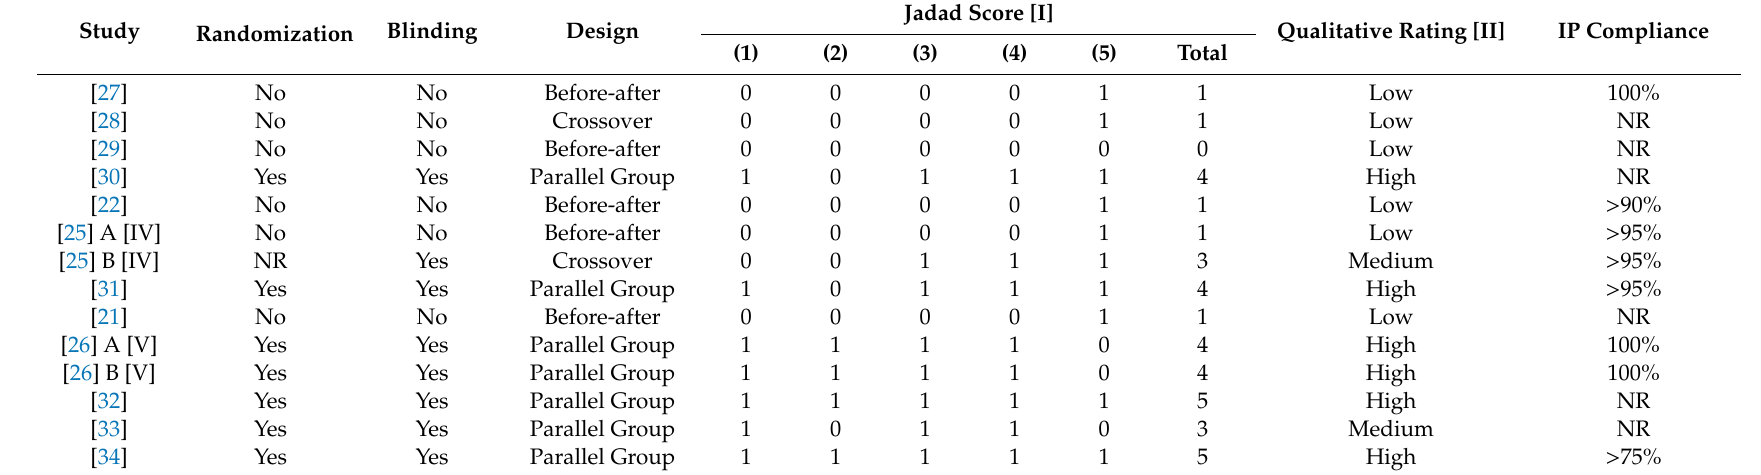
Table 2. Study Design and Quality